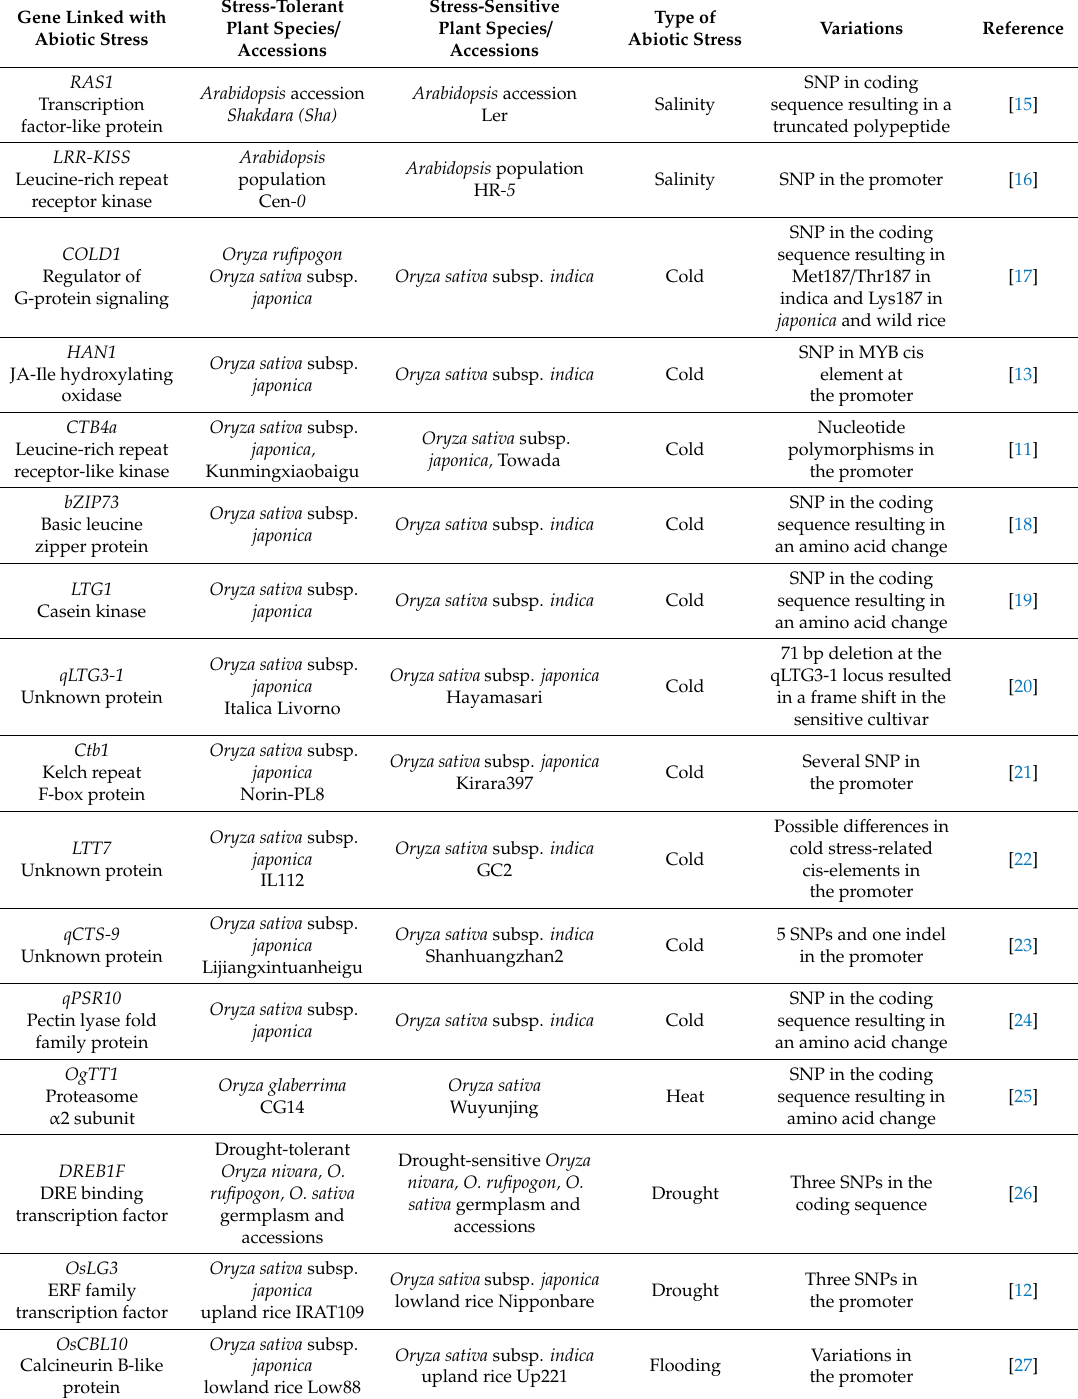
Table 1. Superior alleles from various plants in stress tolerance comparison